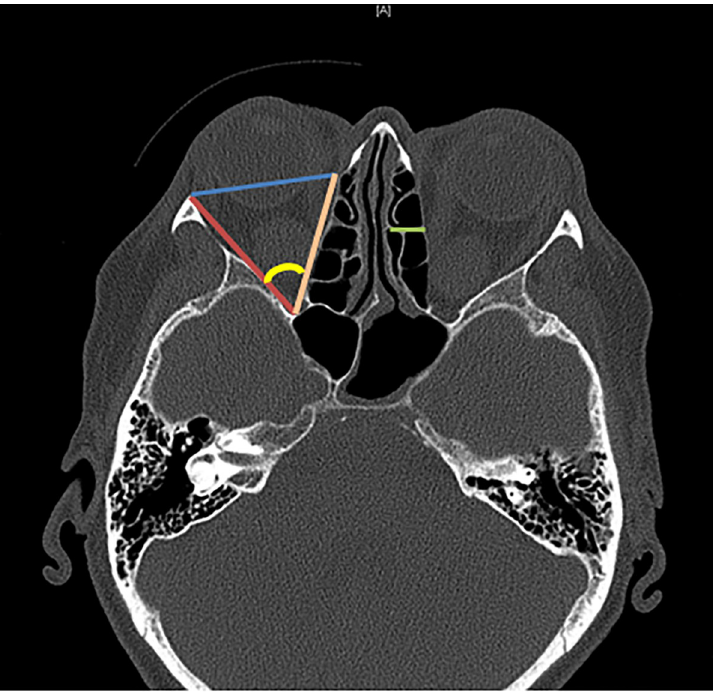
Fig 2. Pre- and postoperative computed tomography images were analyzed. The orbital area was measured as a triangle comprised of lateral (red) and medial orbital wall (orange), as well as orbital width (blue). Furthermore, the conus angle (yellow) and the depth of the ethmoid cavity were measured. Postoperative scans at the same level were used to measure length of medial and orbital defect and depth of medial tissue